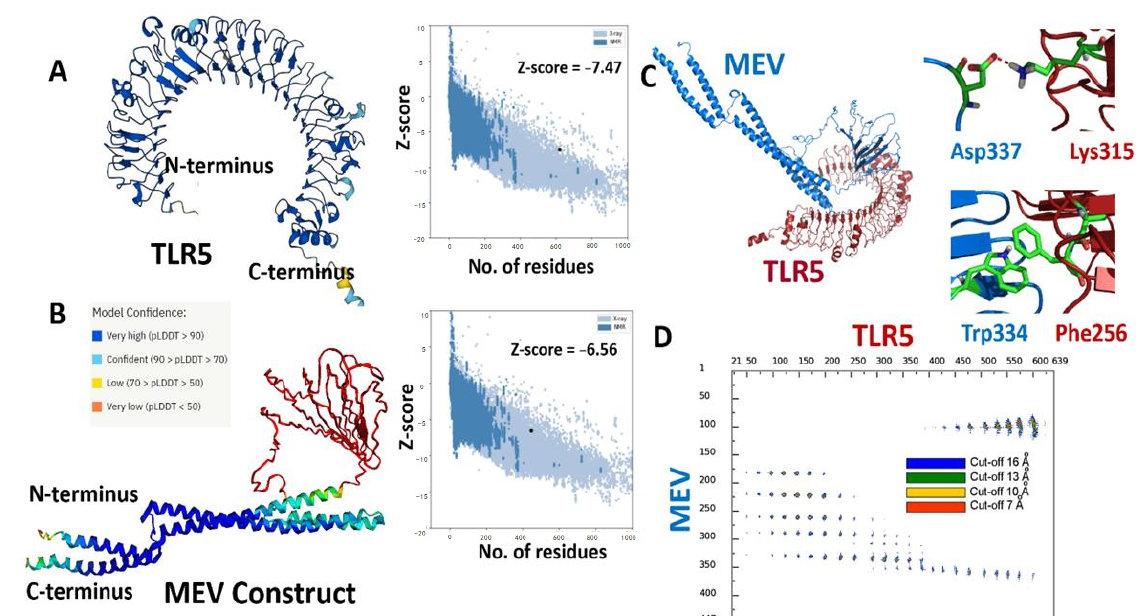
Figure 2. ( A ) Cartoon representations of modeled 3D structures for ( A ) human TLR5; and ( B ) the fungal MEV construct with respective Z-scores calculated by ProSA. ( C ) Cartoon representation of the predicted complex between TLR5 (red) and fungal MEV (blue). ( D ) Distance contact map indicating the residues in contact in the predicted MEV–TLR5 complex at different distance thresholds, along with a stick representation of two representative molecular interactions between them.